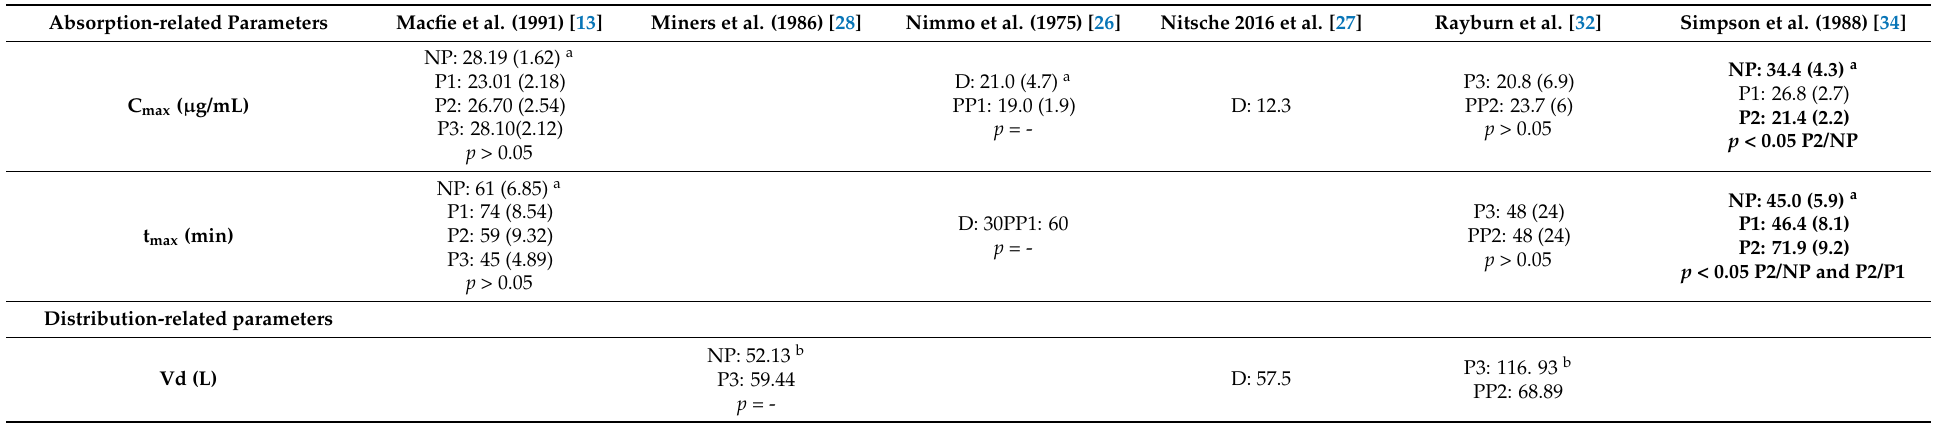
Table 3. Summary of pregnancy-induced changes in the pharmacokinetics, obtained with NCA, of acetaminophen and its metabolites. Studies are presented in alphabetical order by author. Data are given in median [range], mean (SD) unless other use is specified. Absorption-related Parameters Macfie et al. (1991) [13] Miners et al. (1986) [28] Nimmo et al. (1975) [26] Nitsche 2016 et al. [27] Rayburn et al. [32] Simpson et al. (1988) [34]